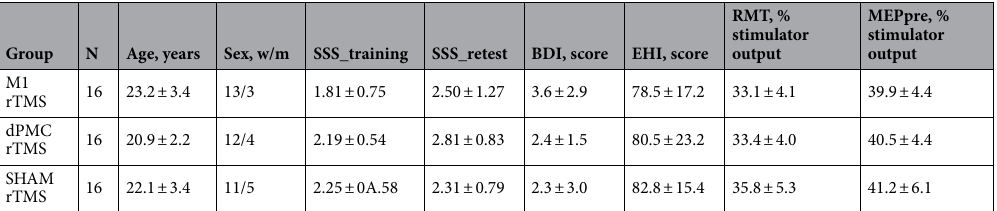
Table 1. Group characteristics. Stanford-Sleepiness-Scale score before training (SSS_training) and before retest (SSS_retest); N number of participants, BDI Beck-Depression-Inventory, EHI